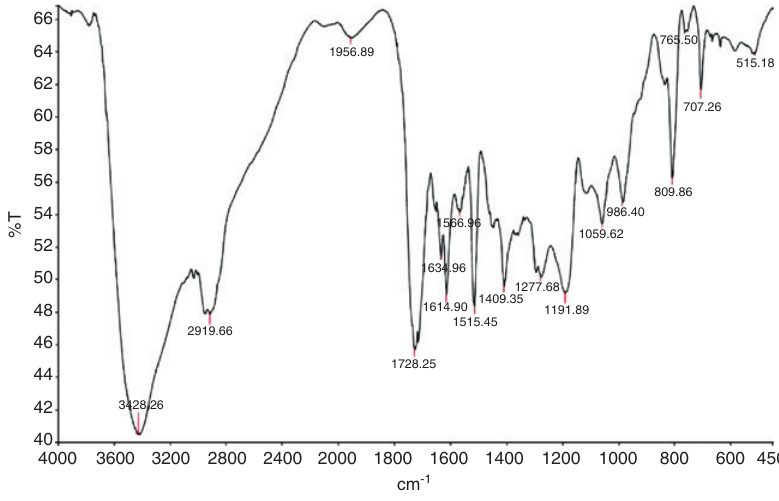
Figure 4: FT-IR spectrum of cured epoxy-acrylate.